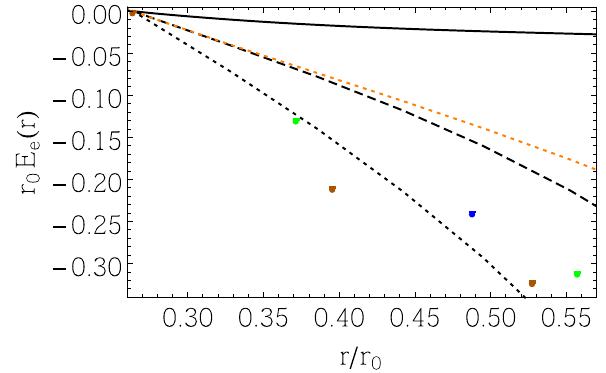
Fig. 9 Comparison to the lattice data for E e . The solid black line cor- responds to the NLO result at fixed scale ν = 2 / 0 . 263821 r − 1 dashed black line corresponds to the NLO result setting ν = 1 / r . The dotted lines correspond to the LL (orange) and NLL (black) results setting ν us = C A α(ν)/ r and ν = 1 /